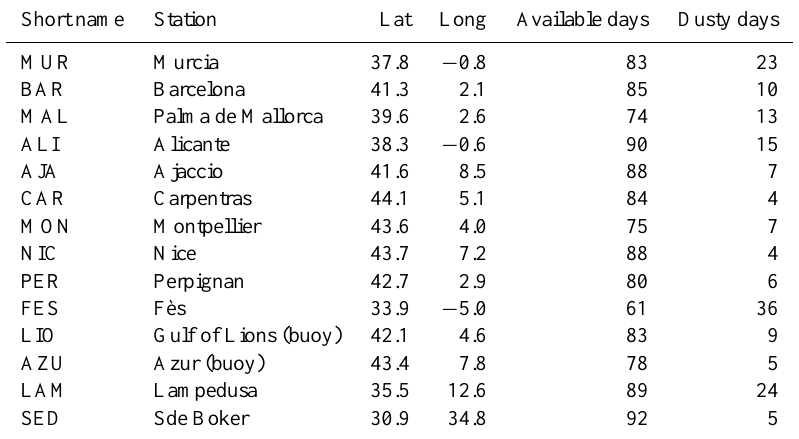
Table 1. Stations used for the composite study. The total number of days when observations are available and among them the number of dusty days have been